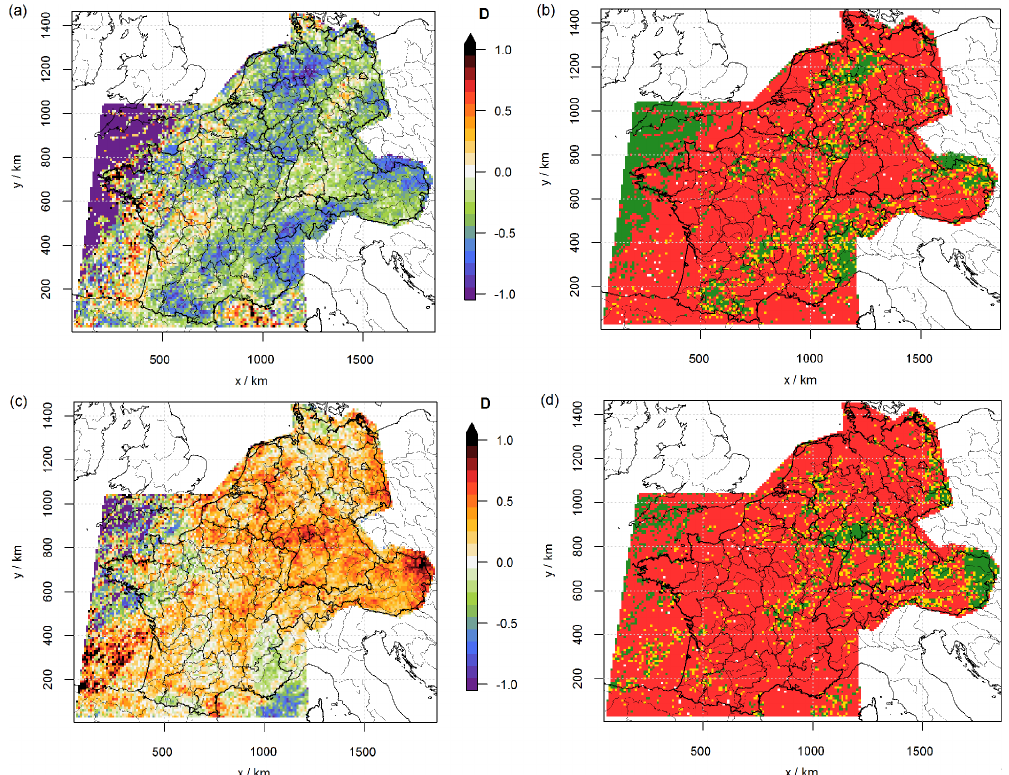
Figure 12. Relative deviation ( D ) of the monthly number of thunderstorm days calculated with respect to months with an NAO index greater than + 1 ( N + ) from that calculated with respect to all months (a) . Results of a bootstrap significance test with green/yellow grid boxes corresponding to areas where the null hypothesis has been rejected with Si = 95% and Si = 90%, respectively, and red boxes denoting acceptance of null hypothesis (b) . The same applies to (c, d) , but D is evaluated with respect to an NAO index below − 1 ( N −